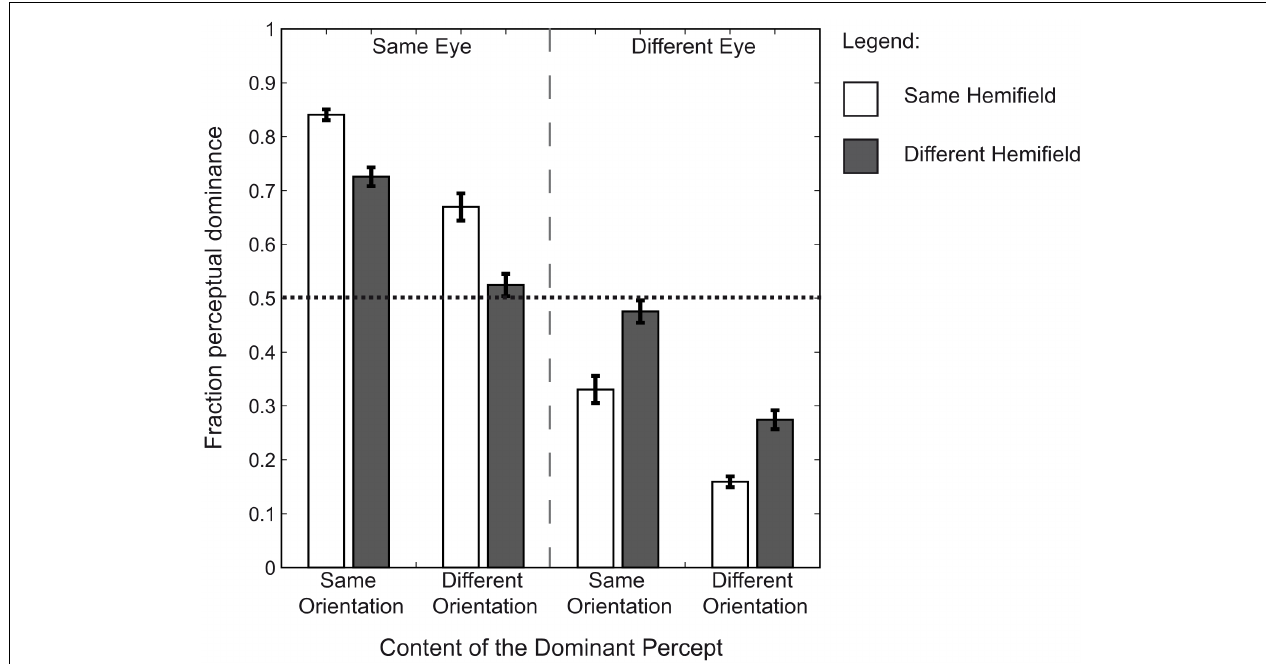
targets are split between the eyes.The bias toward grouping is further increased when identical targets are presented within the same hemifield as well as to the same eye. However, when identical targets are presented to different eyes, the bias is decreased (a bias away from grouping) for presentation in the same compared to different hemifields.These results suggest a strong preference for visual information presented to one eye to be simultaneously